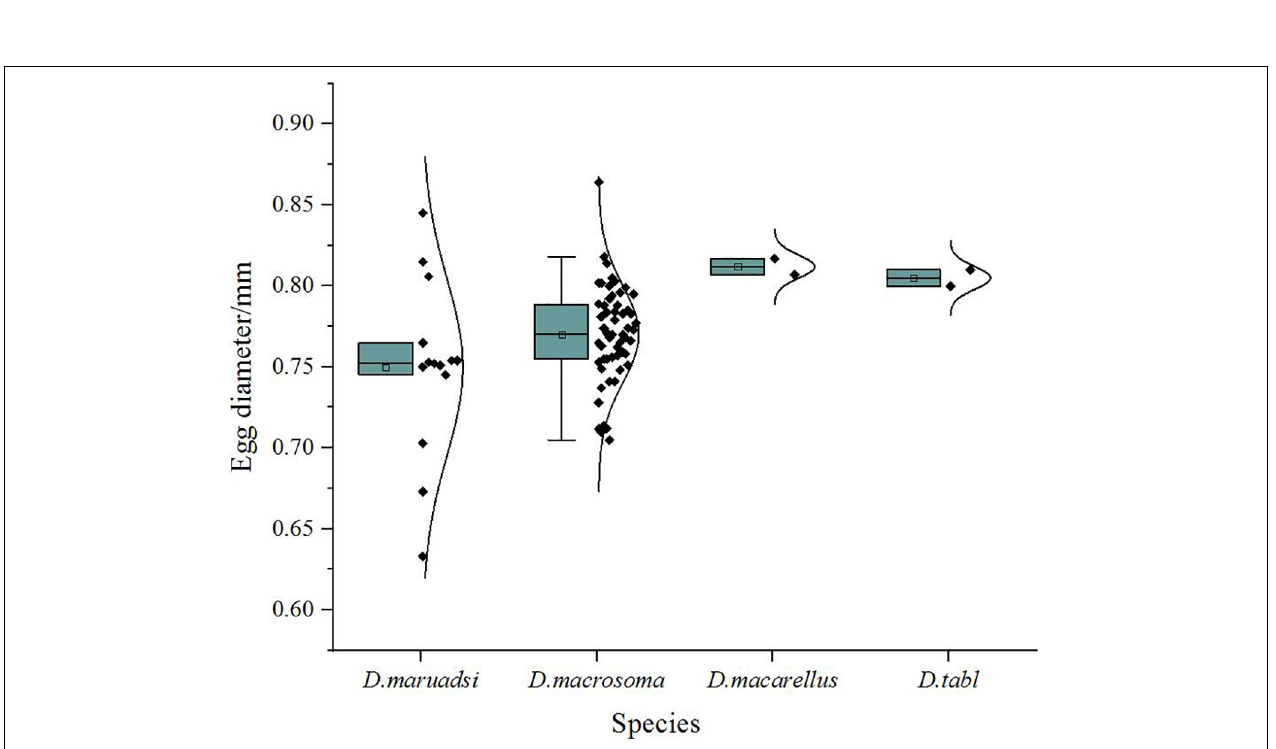
FIGURE 5 | Egg diameter (mm) in Decapterus species, northern South China Sea. Whisker plots depict median, mean, 1st and 3rd quartiles, and ranges (minima, maxima).